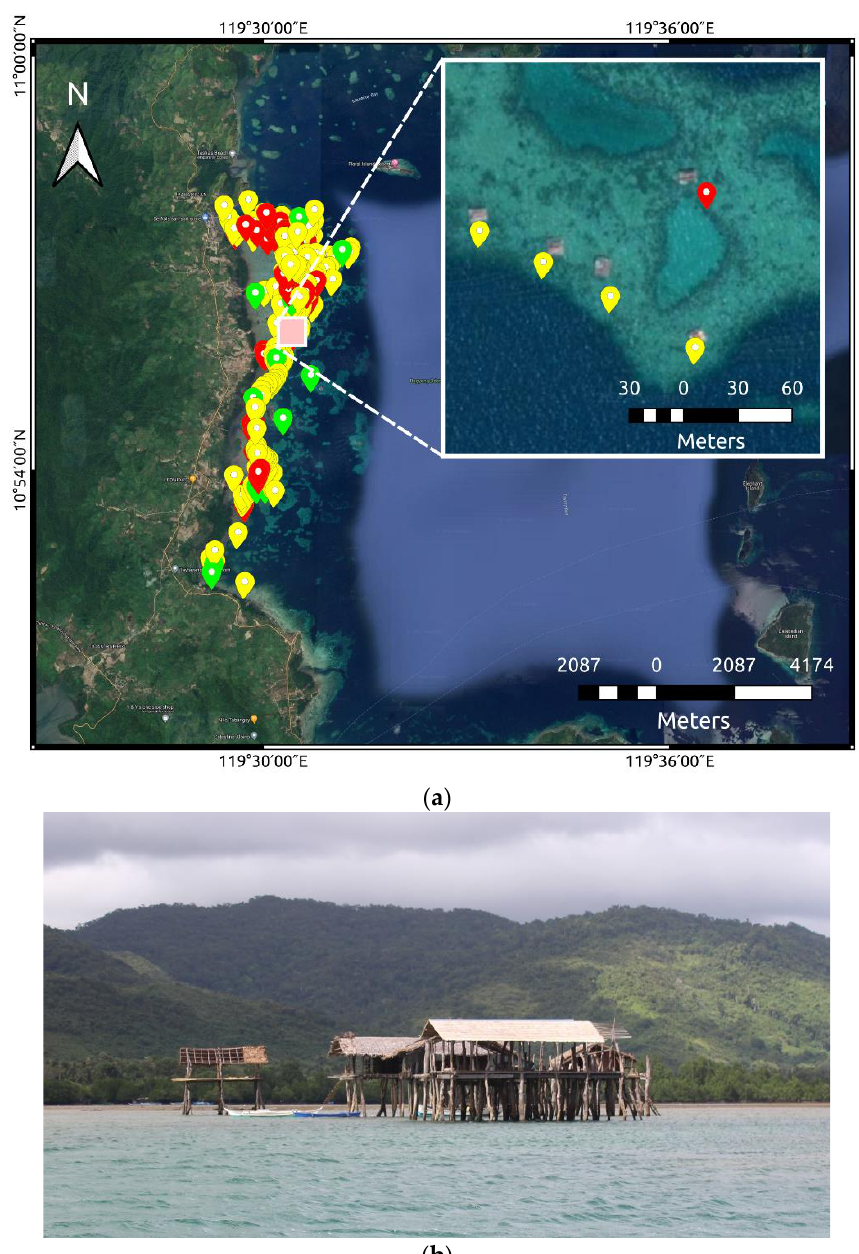
Figure 8. Aquaculture caretaker sheds in Taytay Bay, comparison between aquaculture map and Google Earth images: ( a ) covered area and a larger fragment of the map. True positive detections are shown as yellow balloons, false alarms are shown in green, and undetected objects are shown in red; ( b ) a caretaker shed.